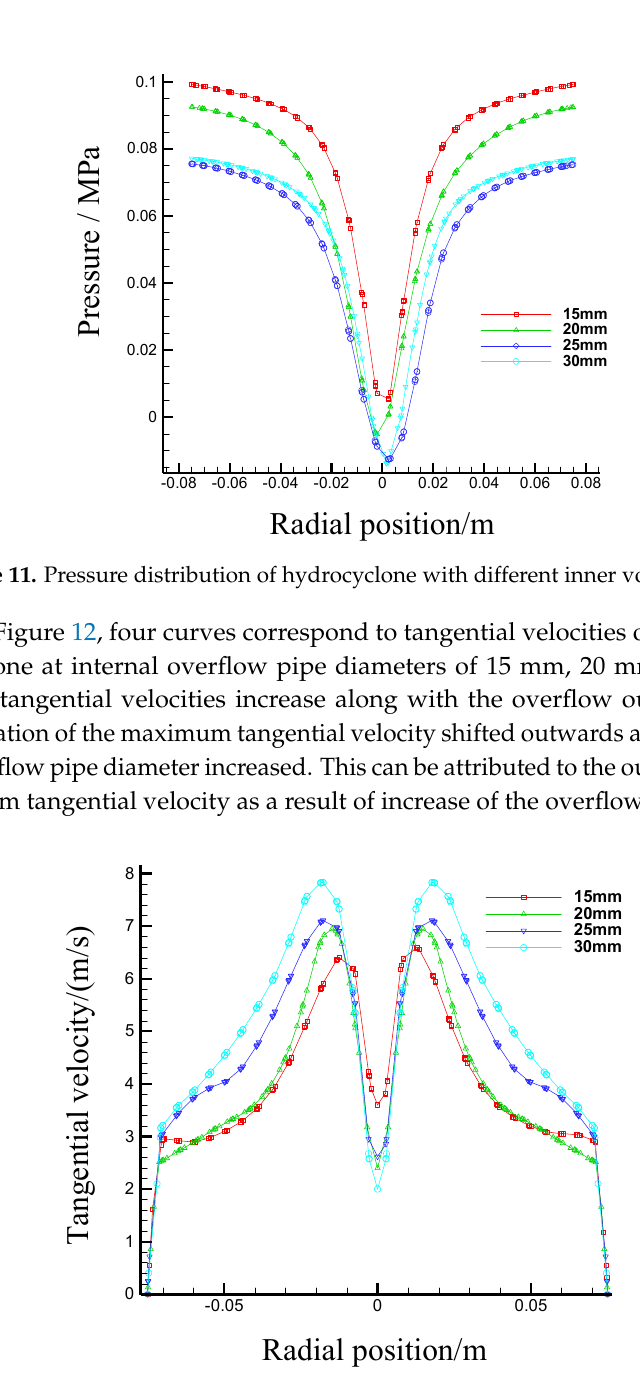
Figure 12. Velocity distribution of the hydrocyclone with a different inner vortex finder.